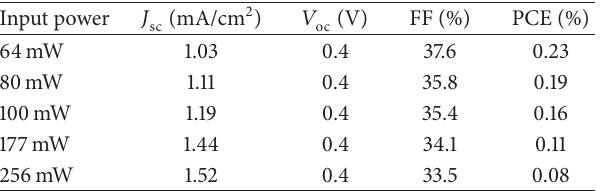
Table 2: OPVs parameters of Cells A prepared under normal condition under different illumination intensities.